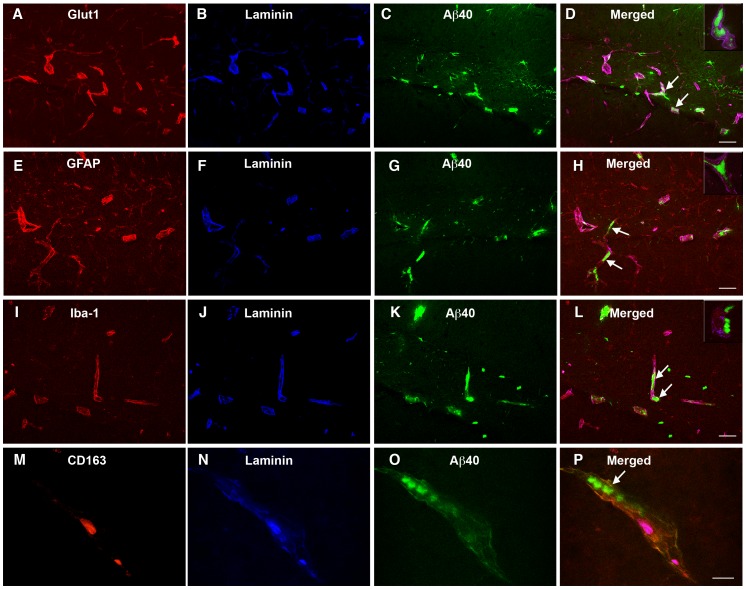
Localization of the Aβ deposits in the blood vessels of 16-month old TRE4 mice.Double labeling immunocytochemistry was used to assess the location of Aβ (green) aggregates (arrows) with respect to laminin-positive basement membranes (blue) in hippocampal arteries and glut-1-positive endothelial cells (red, a–d), GFAP-positive astrocytes (red, e–h), Iba-1-positive juxtavascular microglia (red, i–l) and CD163-positive perivascular macrophages (red, m–p). No co-localization was observed between Aβ aggregates and any cell type, suggesting that the Aβ deposits do not represent intracellular aggregates. Inserts represent x63 magnification. Scale bar: a–1 = 50 µm; m–p = 25 µm.